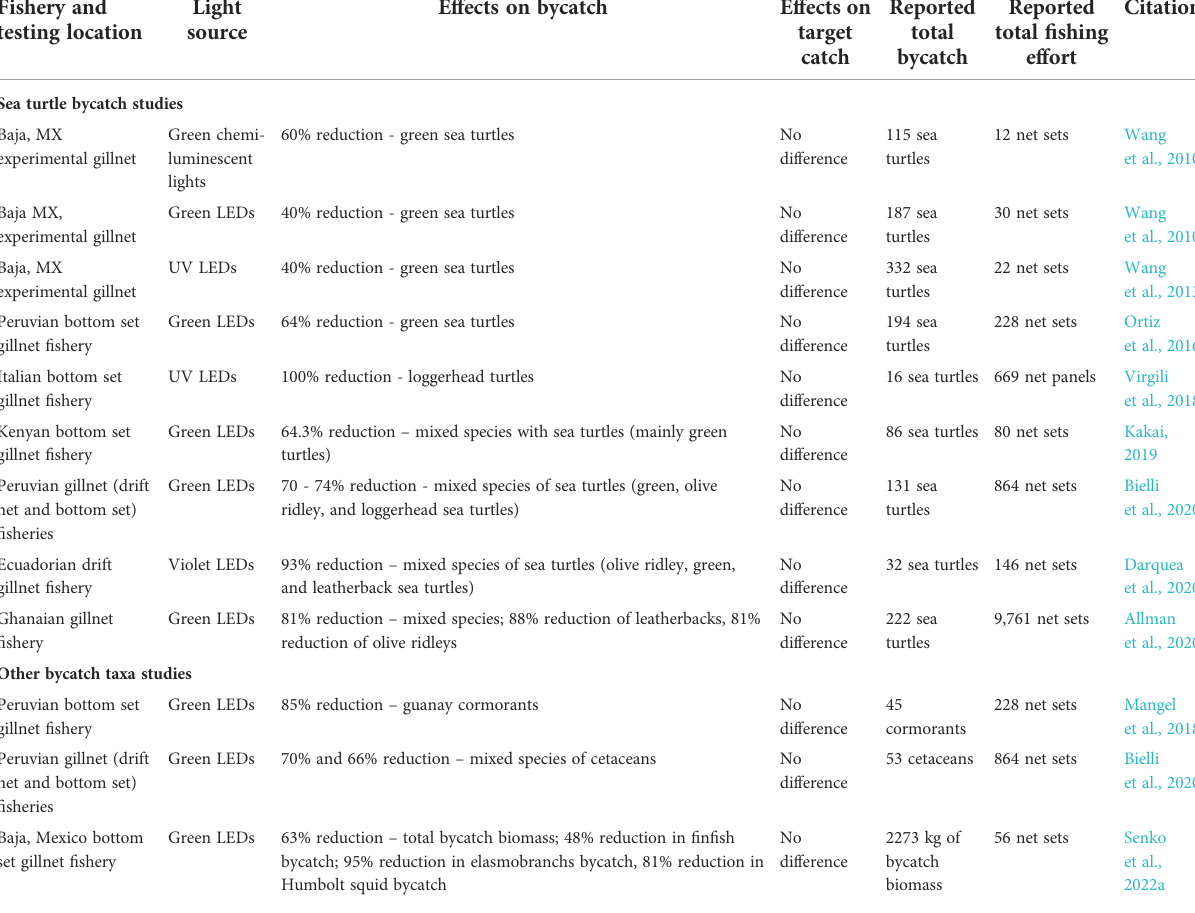
TABLE 5 Published studies testing net illumination as a bycatch reduction technology. Fishery and testing